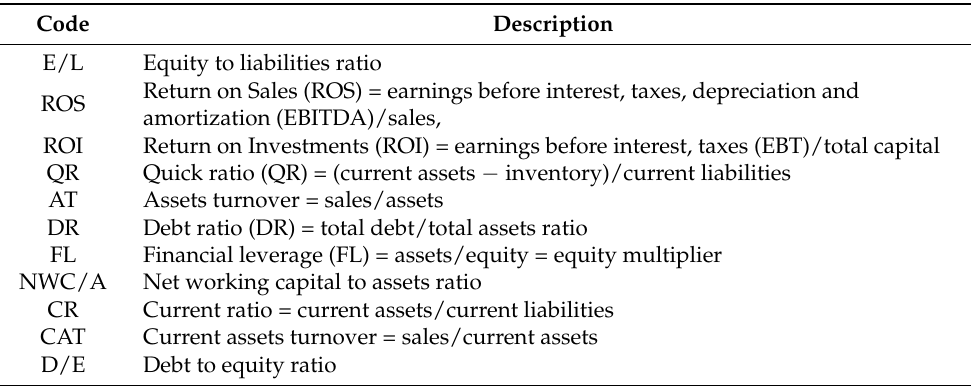
Table 2. Variables entering the